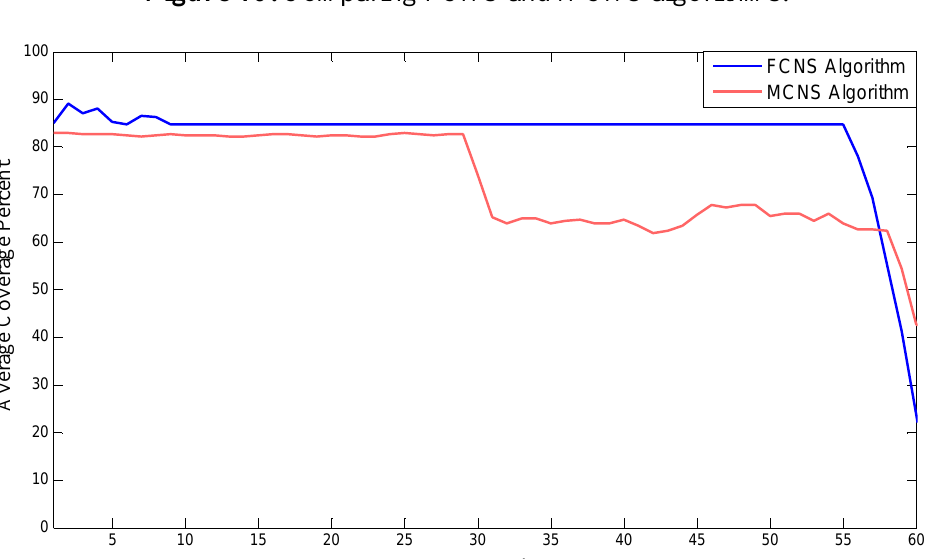
Figure 10. Comparing FCNS and MCNS